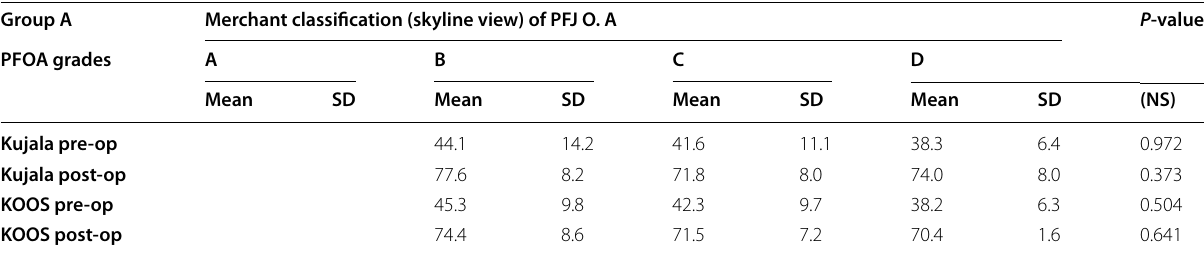
Table 10 Correlation between Merchant classification (skyline view) of PFJ O.A and outcome in group A Group A Merchant classification (skyline view) of PFJ O. A